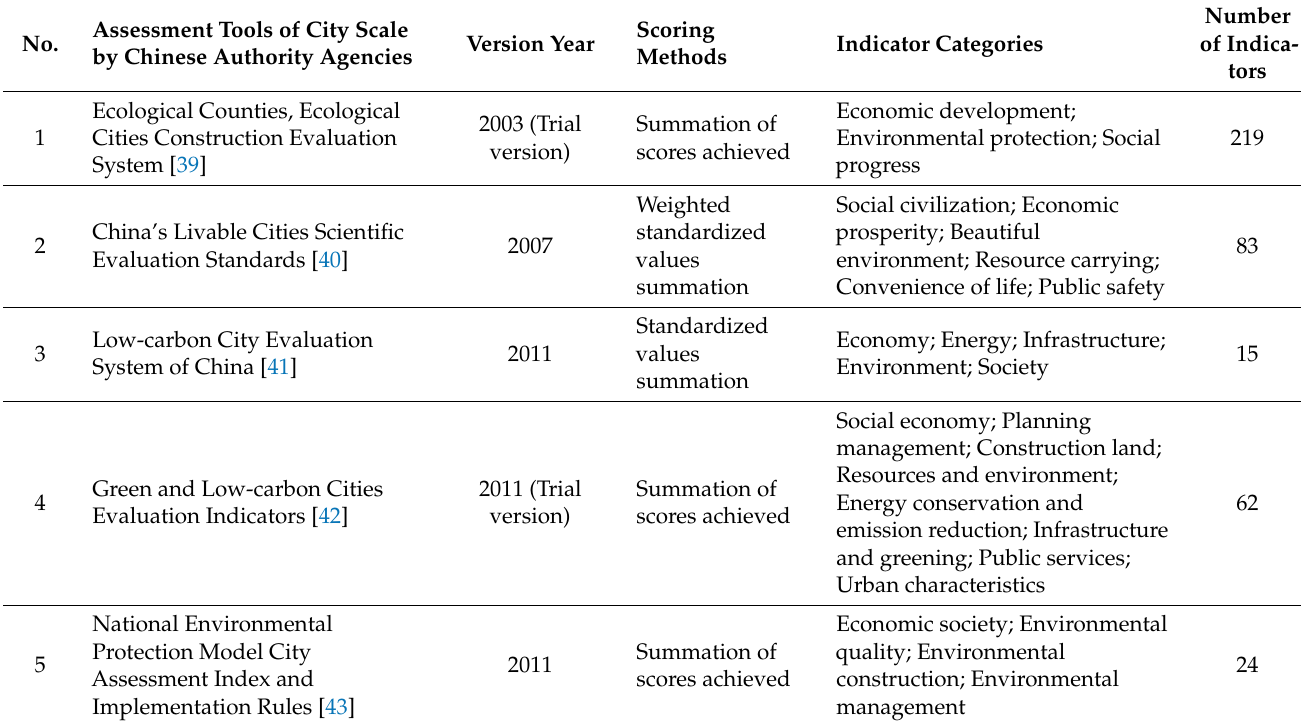
Table 1. The general list of 14 Chinese urban sustainability assessment